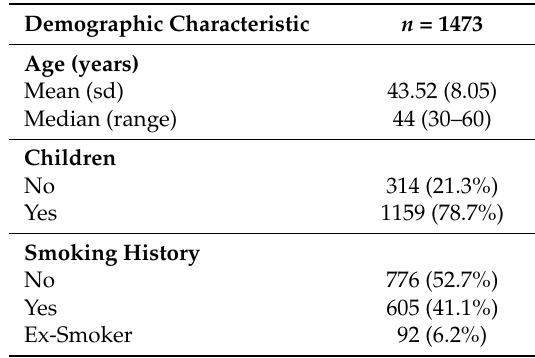
Table 1. Demographic characteristics of the study